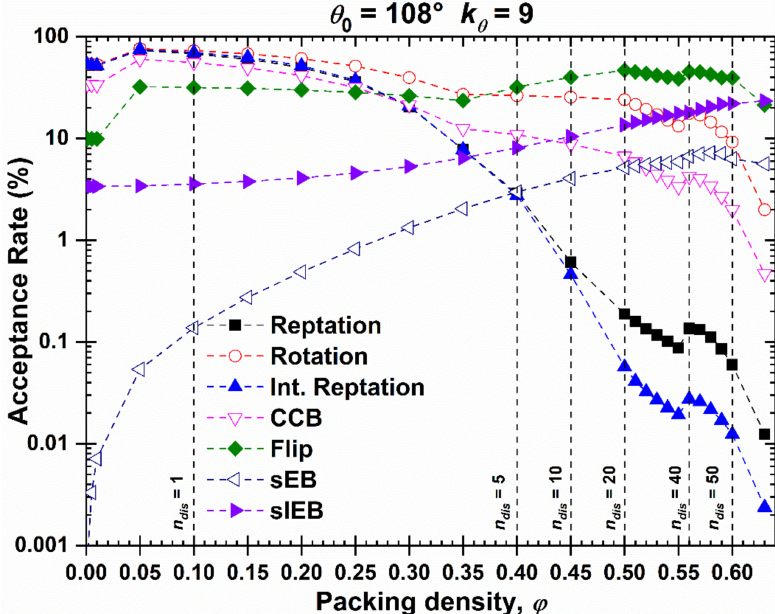
Figure 5. Percentage of acceptance as a function of packing density for the local and chain- connectivity-altering moves employed in the MC simulation of 48 chains of N = 100, θ 0 = 108 ◦ in the bulk. Vertical dash lines denote the end of the regime where n dis trial configurations are attempted per local MC move.